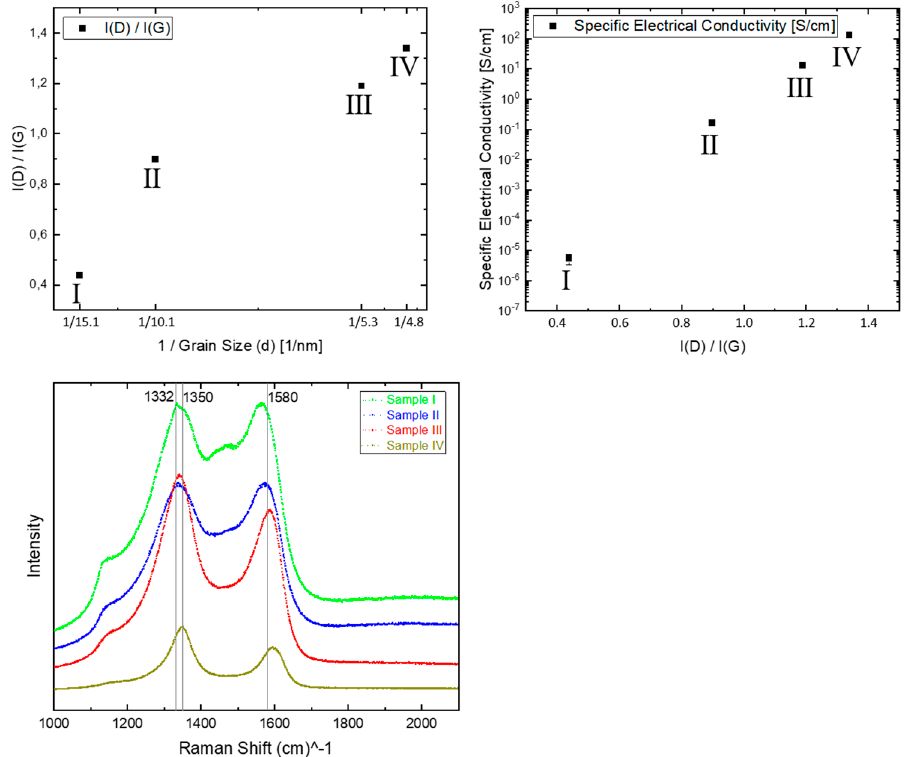
Figure 4. Evaluation of the correlation between the intensity ratio of D-peak and G-peak, namely I(D)/I(G), with diamond grain size (top-left) and with specific electrical conductivity (top-right), I(D)/I(G), with diamond grain size ( top-left ) and with specific electrical conductivity ( top-right ), based on Raman-spectra (bottom) of four diamond film samples. based on Raman-spectra ( bottom ) of four diamond film